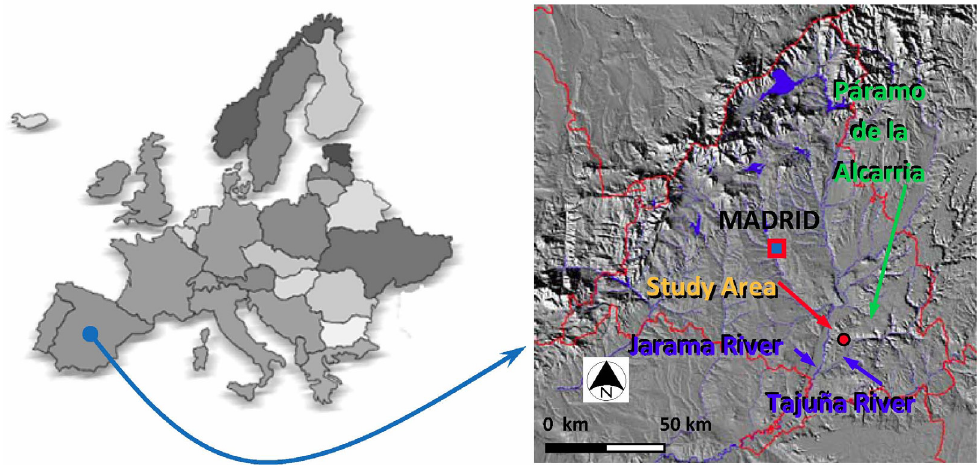
Figure 1. Geographical situation of the study area.